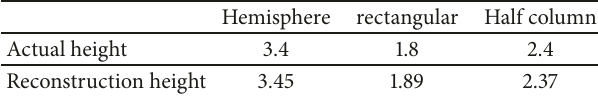
Table 1: Comparison of actual height and reconstruction